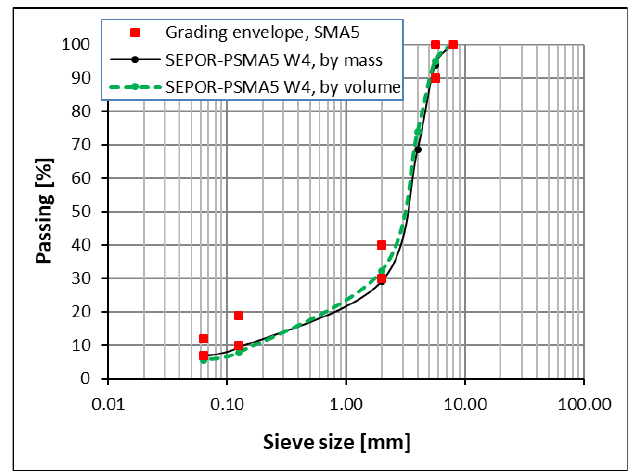
Figure 3. SEPOR-PSMA5 W4 grading curve.